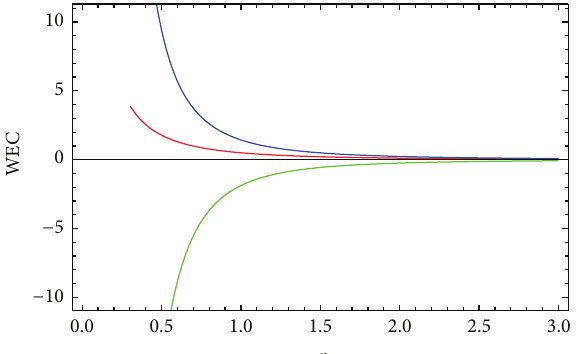
Figure 3: Plots of WEC: 𝜌 versus 𝑟 (red curve), 𝜌+𝑝 𝑟 versus 𝑟 (green curve), and 𝜌 + 𝑝 𝑡 (blue curve) versus 𝑟 for exponential model.